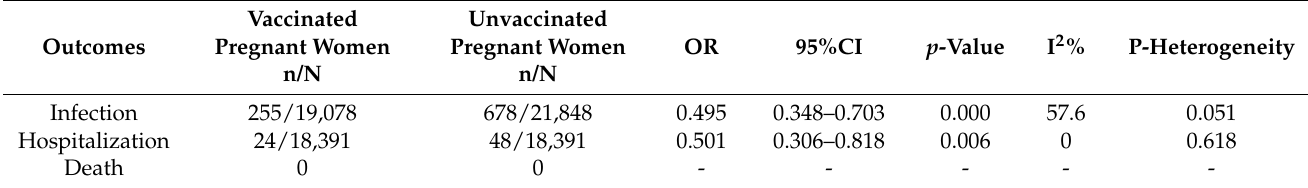
Table 5. Effectiveness of COVID-19 vaccine among pregnant women.